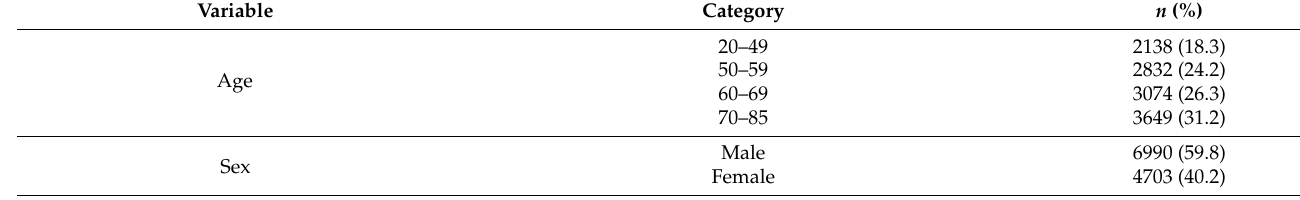
Table 3. Characteristics of the study subjects ( n =